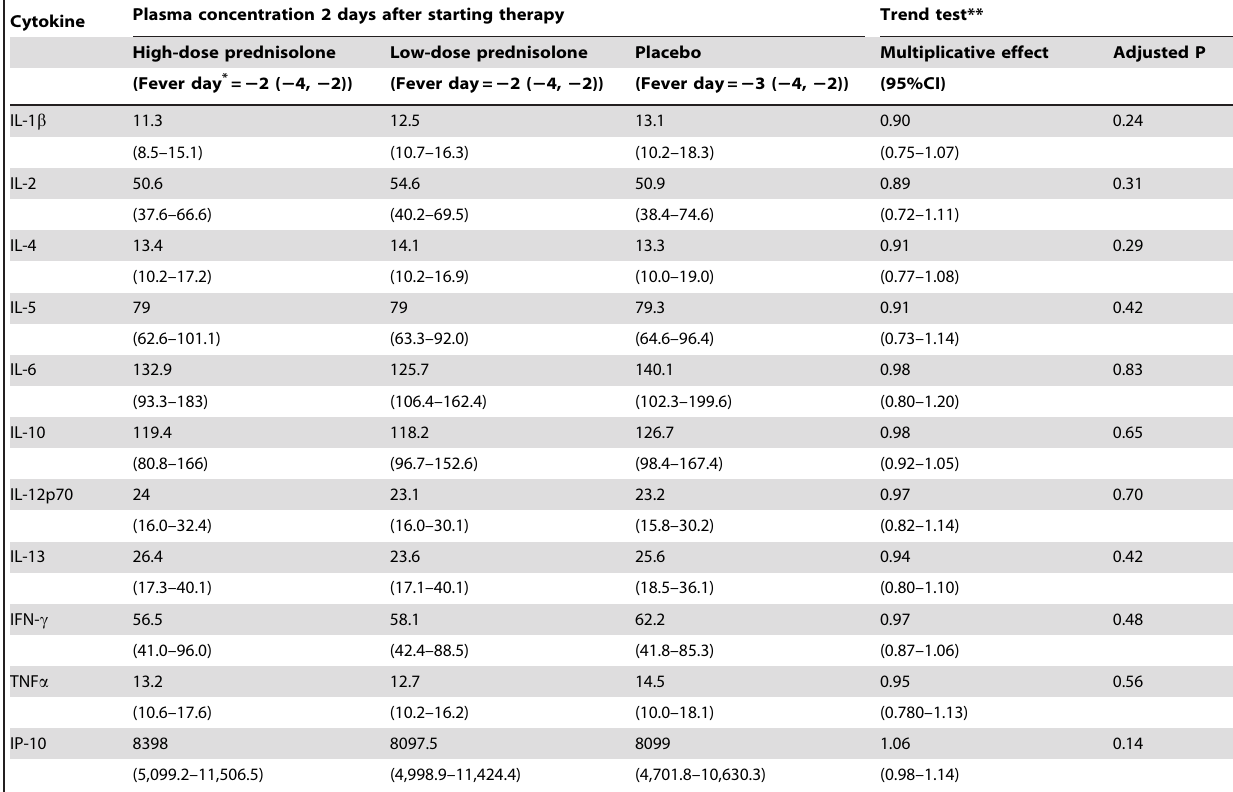
Cytokine Plasma concentration 2 days after starting